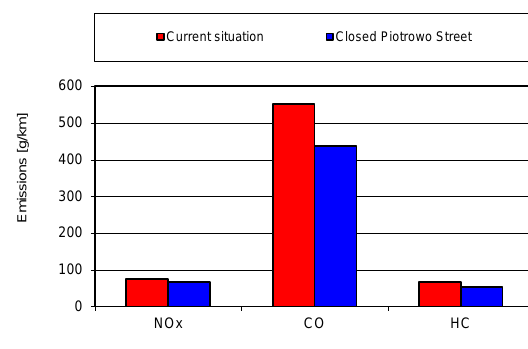
Fig. 6. Emissions of vehicles in the afternoon peak at Jana Pawła II Str.